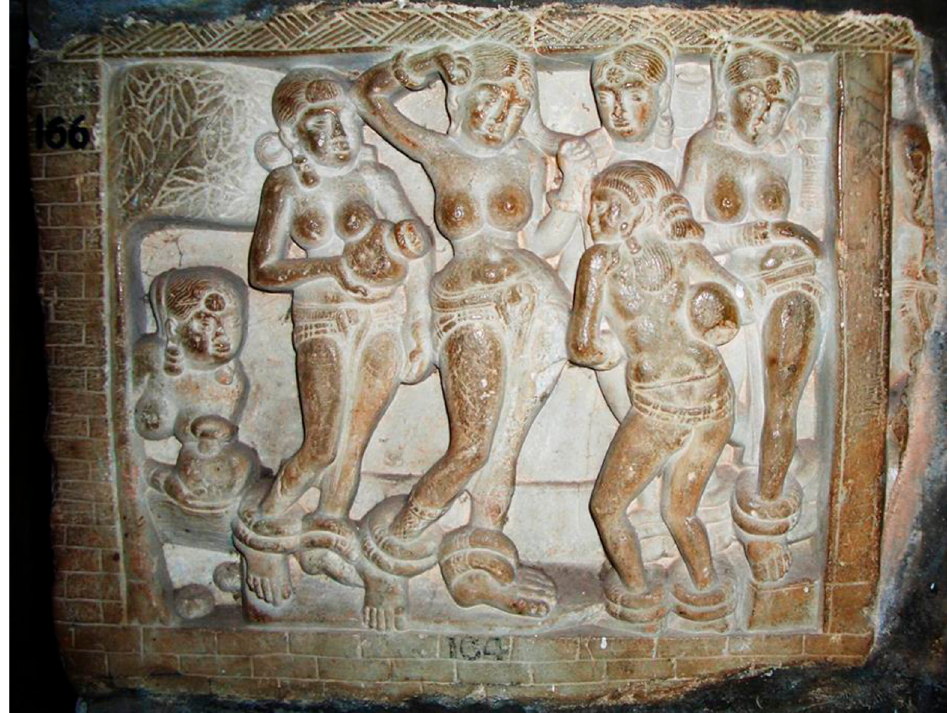
Figure 3. Amaravati, Chennai Government Museum, no. 166 © photograph Wojtek Oczkowski.